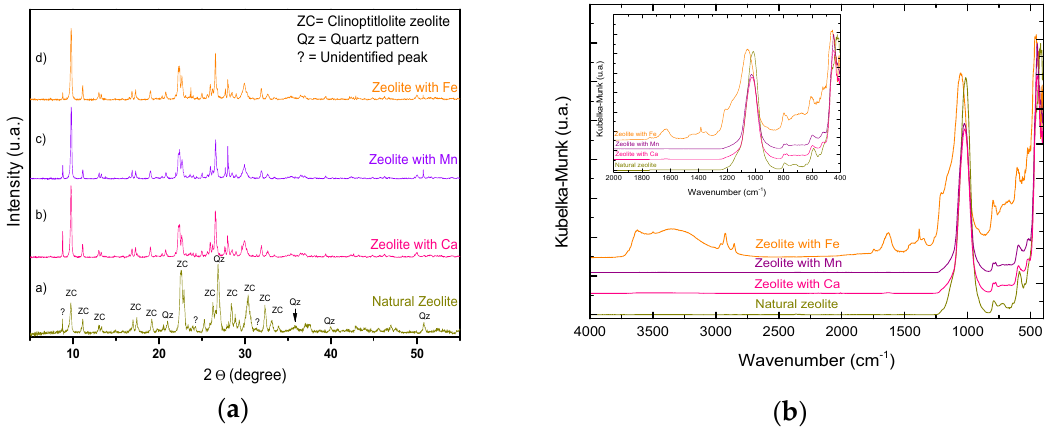
Figure 1. Natural zeolite and zeolites conditioned with calcium, manganese and iron, ( a ) XRD Diffraction, ( b ) FTIR spectroscopy.